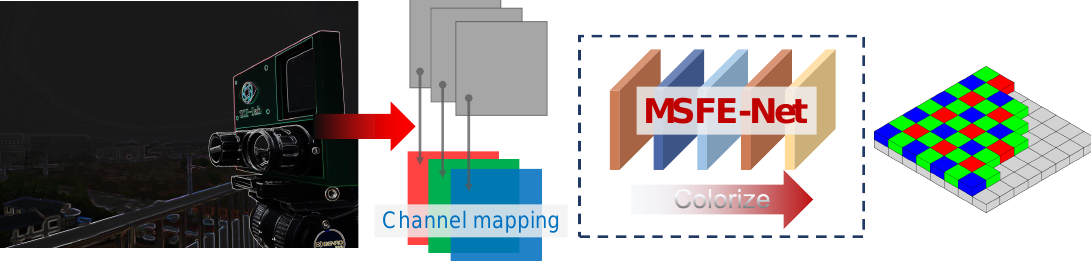
Figure 9. The colorization network framework for the RGB